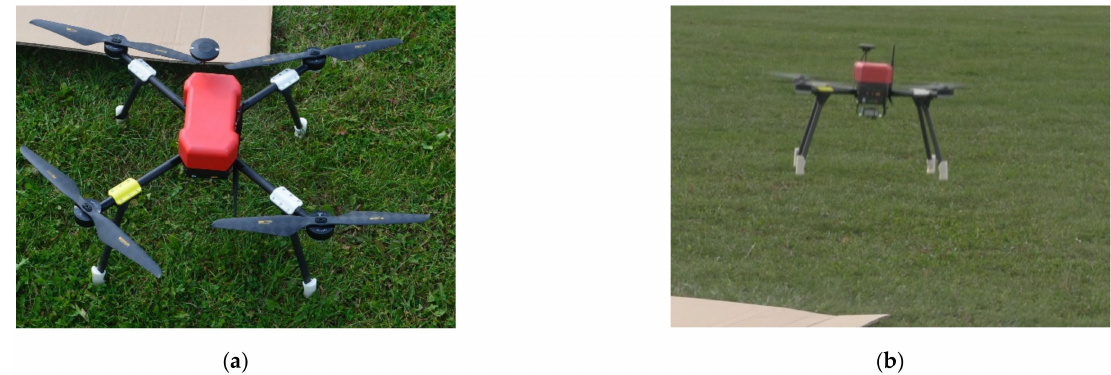
Figure 9. Quadrotor during the flight tests: ( a ) drone ready to fly and ( b )